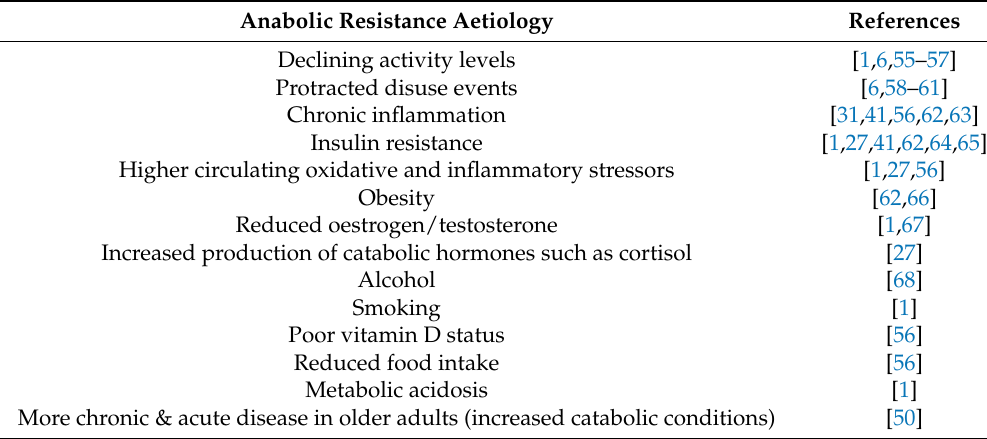
Table 1. Factors influencing anabolic resistance.